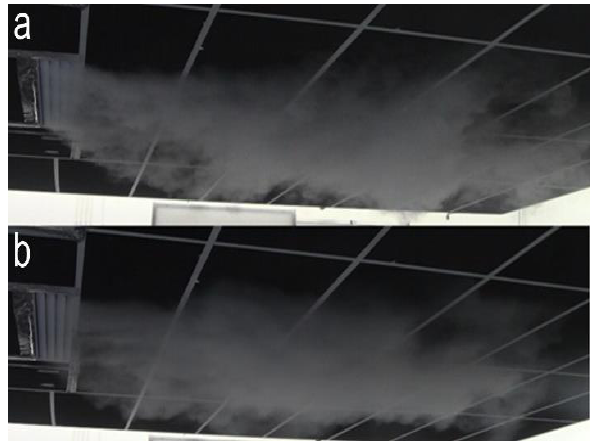
Fig. 8 . Smoke test of the SLN diffuser with outflow along with the ceiling, for two air streams: (a) - 120 m 3 /h, (b) - 480 m 3 /h. Figure 9 shows the velocity distributions in the NSAL diffuser axis with the outflow vertically down for different airflow values. As the distance from the supply air outlet decreases, the velocity decreases reaching 0.64 m/s (for flow 480 m 3 /h) at the lowest measuring point (2.45m from the diffuser). For the lowest flow rate, the velocity of 0.2 m/s was achieved at a distance of 1.7 m from the diffuser.